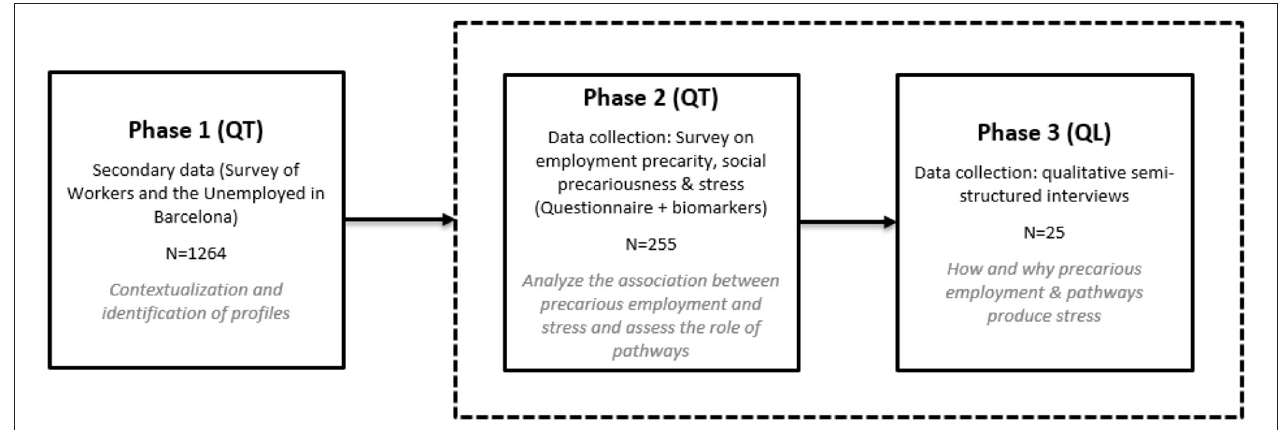
FIGURE 2 | Flowchart of the PRESSED project study design. Sequentiality and interpretive integration of the phases, methods, sample size and objectives. Source: authors’ own Phases 1 and 2 were conducted between 2018 and 2020, while Phase 3 will be conducted in